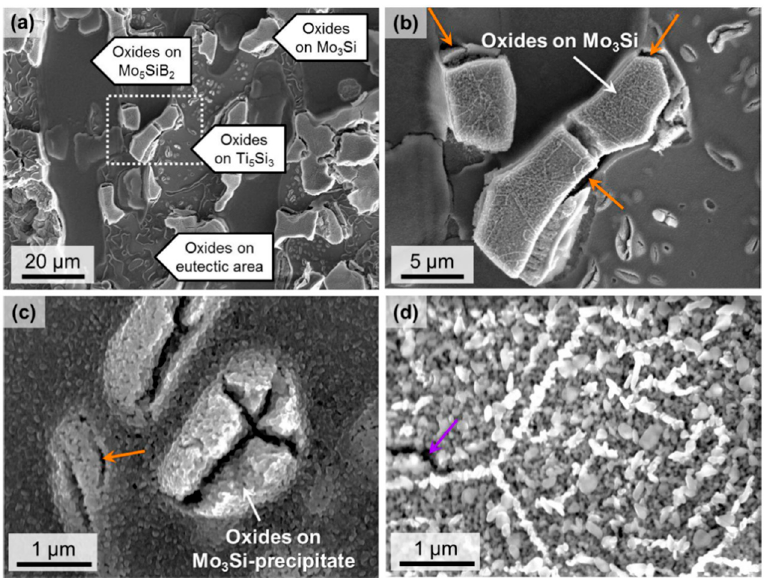
Figure 14. ( a ) Surface morphology of Mo–30Ti–20Si–10B (at.%) oxidized at 800 °C for 5 min. ( b ) is the enlarged image of the dashed square in ( a ). ( c ) shows the appearance of A15 precipitates within D8 8 after oxidation. ( d ) is a high-resolution image of surface oxides on primary A15 [48]. All of them are SEM-SE images.